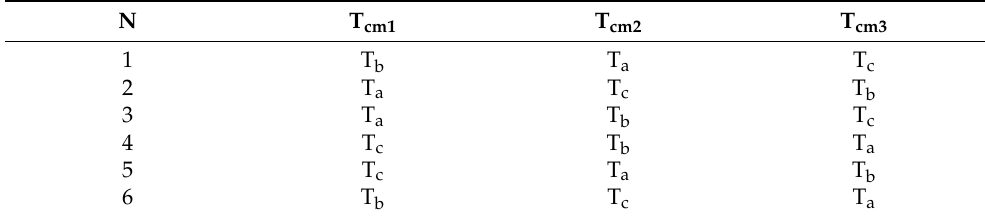
Table 3. Switching schedule of each